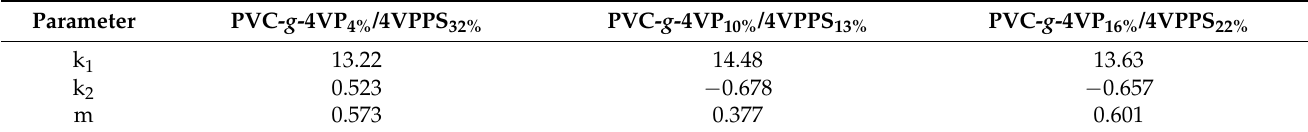
Table 3. Peppas–Sahlin model